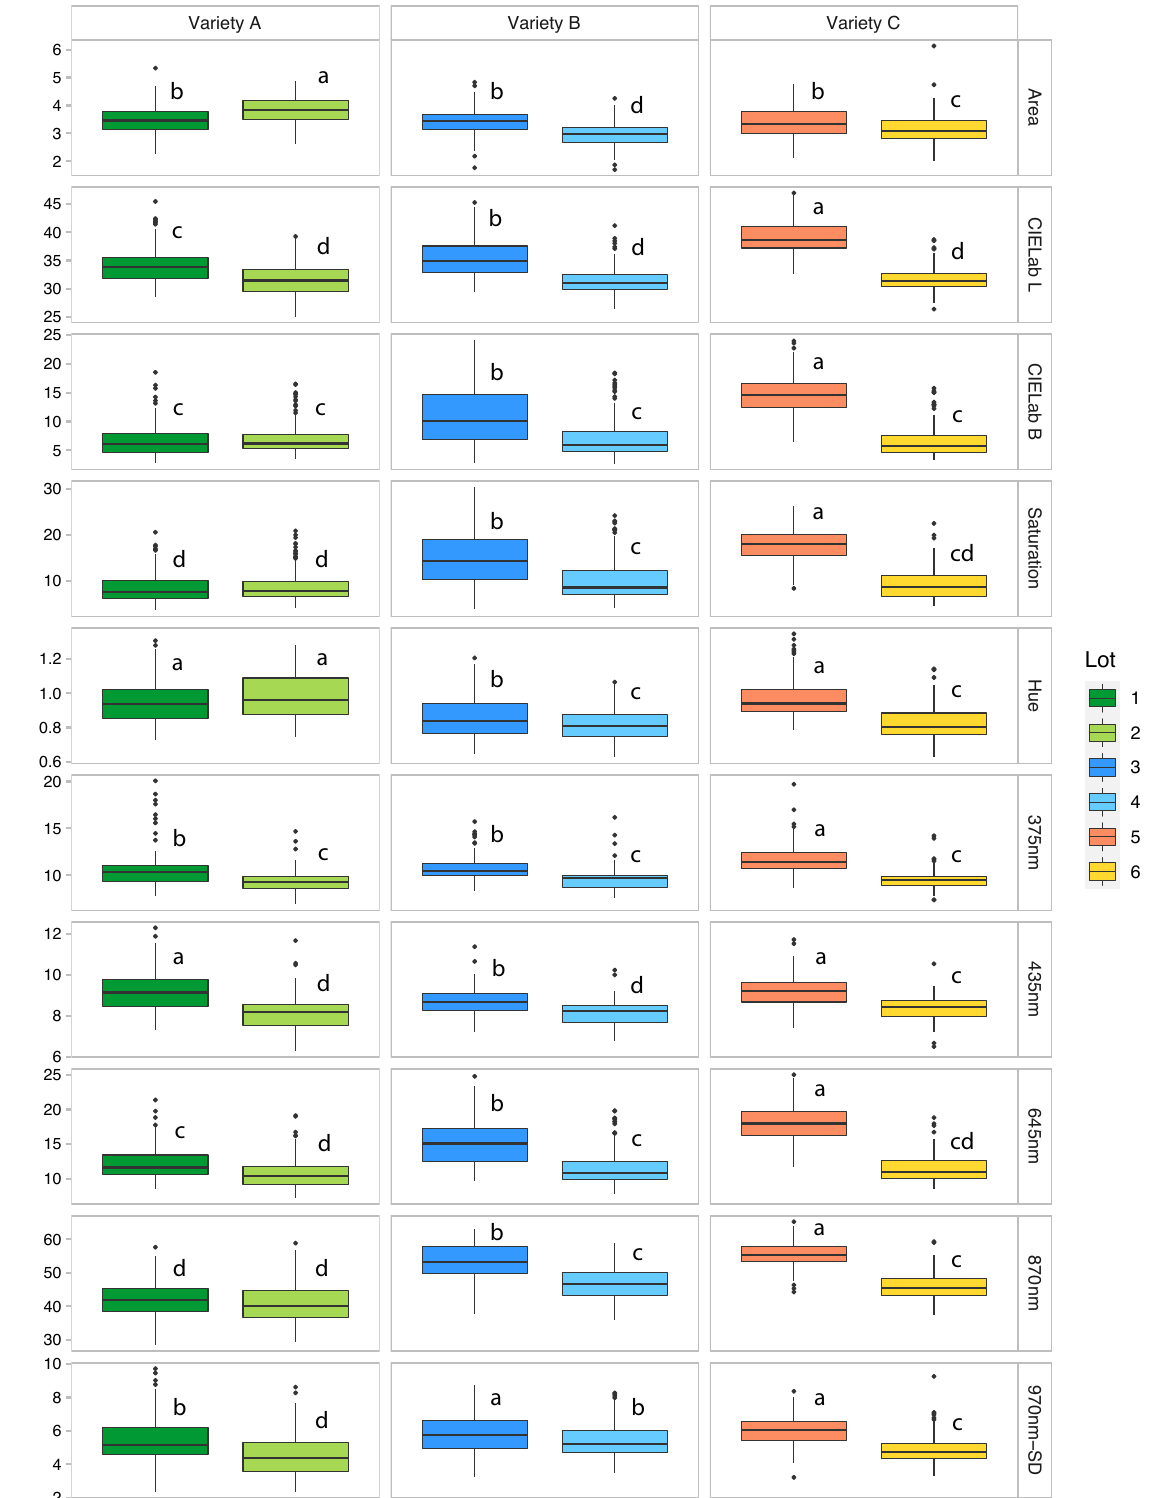
Figure 3. Selected Videometer features (Table 1) across varieties (columns) and seed lots (color-coded). Letters indicate significance between all lots for each parameter (rows) as calculated by ANOVA and Tukey